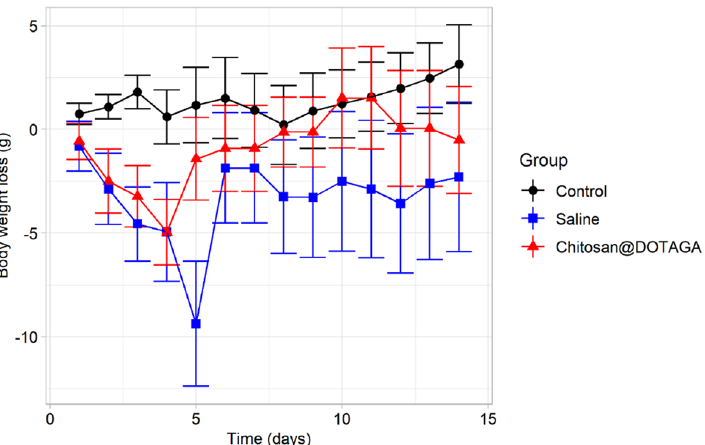
Figure 4. Relative change in body mass over 14 day experimental period. Over the course of 15 days, the trend in relative body weight compared to body weight at day 0 can be observed in the three population of mice. The saline-treated mice and Chitosan@DOTAGA-treated mice underwent an overall decrease in body weight in the first few days, but was quickly normalized.